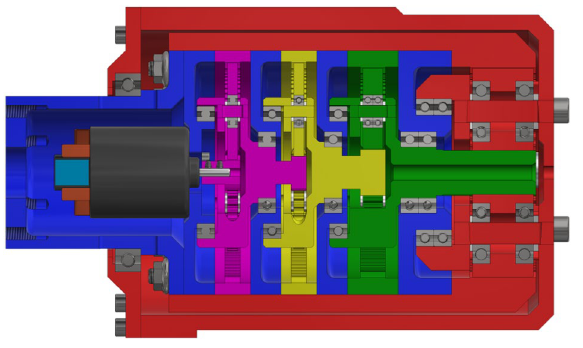
Figure 2. Section view of the